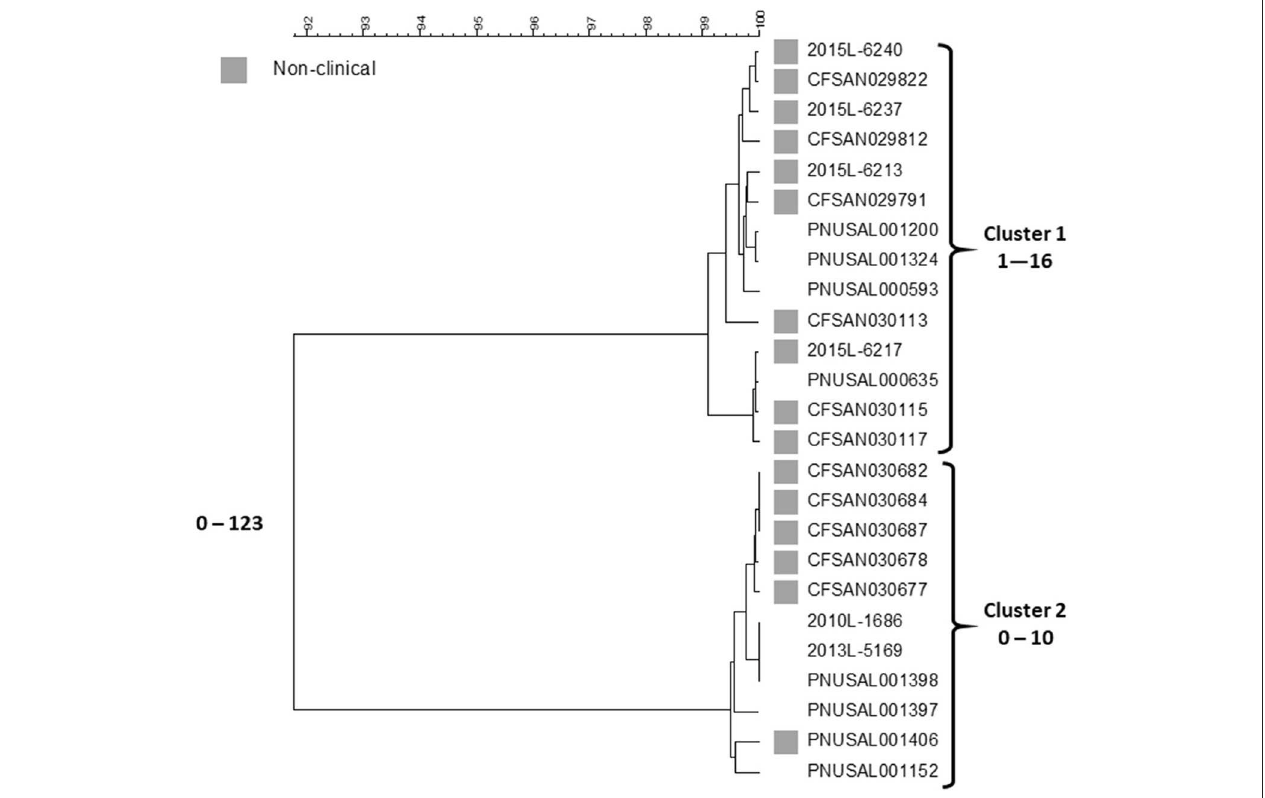
FIGURE 1 | cgMLST UPGMA tree of Lineage I isolate sequences the Listeria outbreak linked to ice cream. All clinical isolates and a representative sample of non-clinical product and production environment isolates are included in the tree. The range of allele differences are indicated at the branches of the tree and for clusters to the right of the